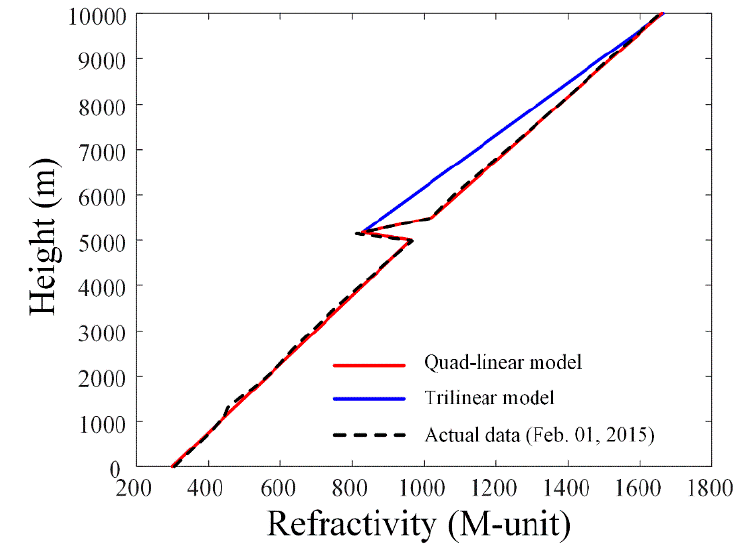
Figure 4. Quad-linear and trilinear modeling comparisons concerning actual refractivity data obtained at the Osan meteorological observatory on 1 February 2015.